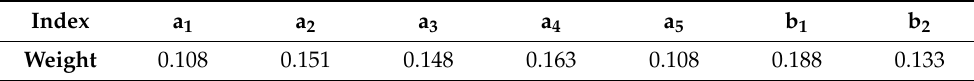
Table 4. Weights of evaluation indicators for 88.2 kW power machinery.